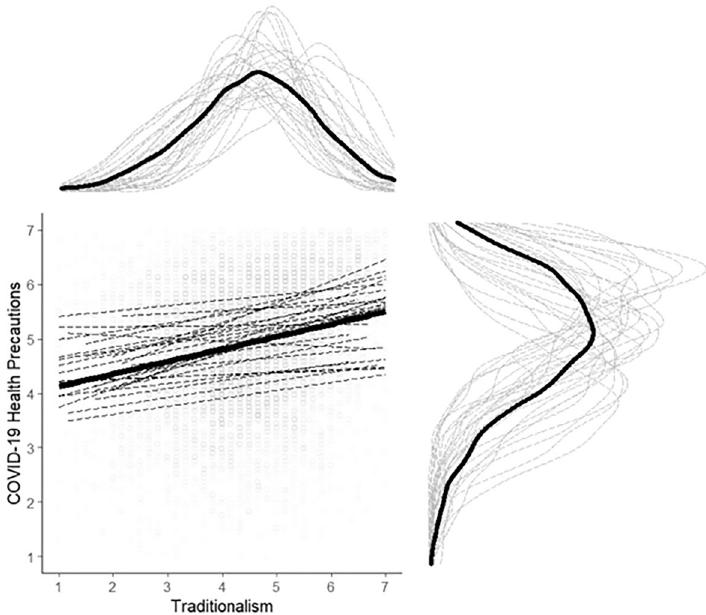
Figure 2. Graphical visualization of the country-specific correlations listed in Fig. 1. Dotted lines are study site-specific product-moment correlations between traditionalism and COVID-19 health precautions. The solid thick line is the unweighted product-moment correlation in the pooled sample across all study sites. Dots show individual data points, jittered along the x- and y-axes to aid interpretability. Density plots along the x- and y-axes represent the raw distributions of the traditionalism and COVID-19 health precautions composites. Thin grey lines show density distributions at individual study sites, whereas the thick black lines show the overall distribution in the pooled sample across all study sites. Study sites are unlabeled to improve readability. For labeled study-site specific correlations and density distributions, see Figs. S2–S4 in the